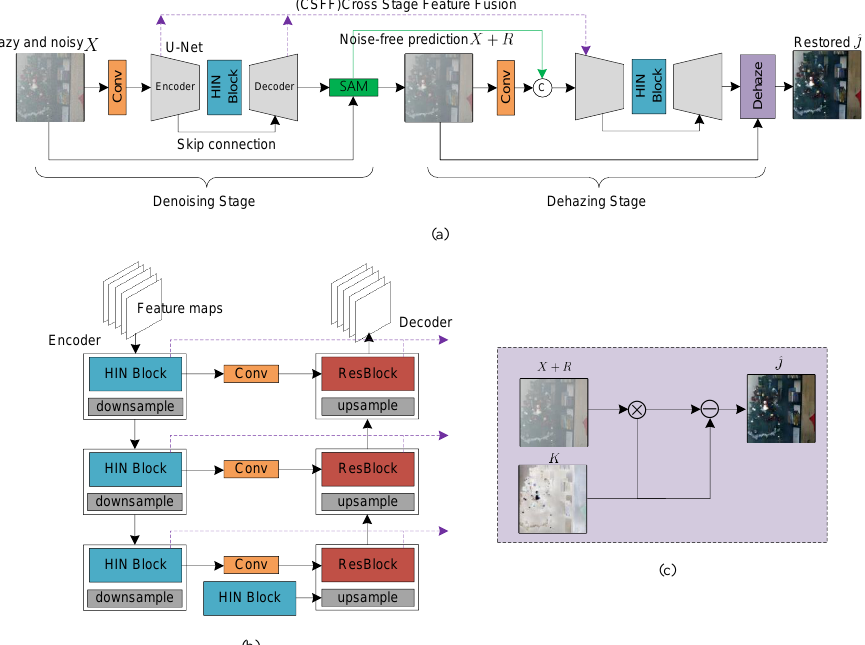
Figure 2. Network architecture and its components. ( a ) Overall CDDNet architecture. ( b ) U-Net with the CSFF module. We only show three layers for simplicity. ( c ) Dehazing